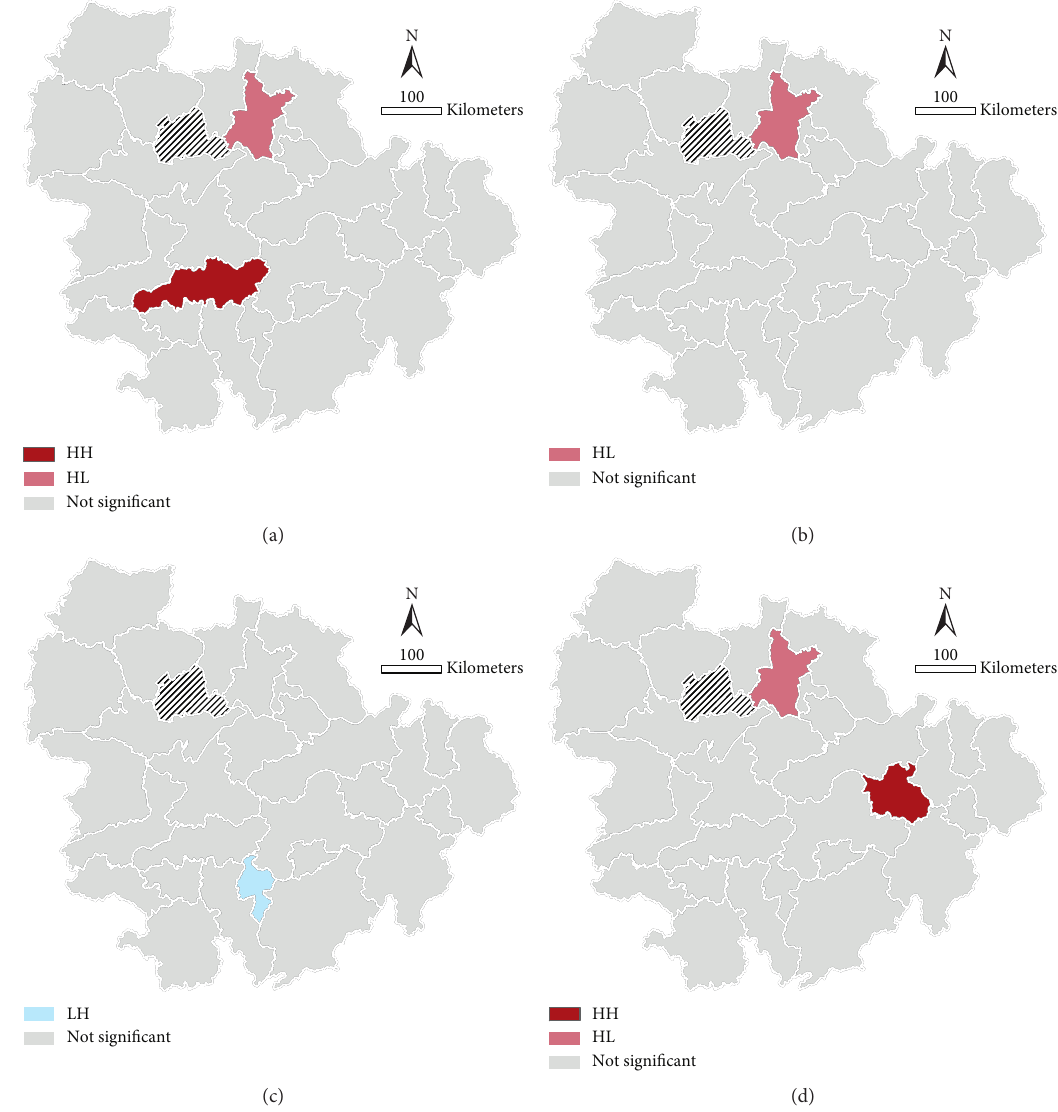
Figure 9: LISA clustering distribution of urban innovation and entrepreneurship index in (a) 2002, (b) 2007, (c) 2012, and (d)